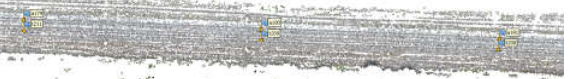
Figure 2. The top view of photogrammetric models (Left: the whole surveying area, Right: straight part of the surveying area)